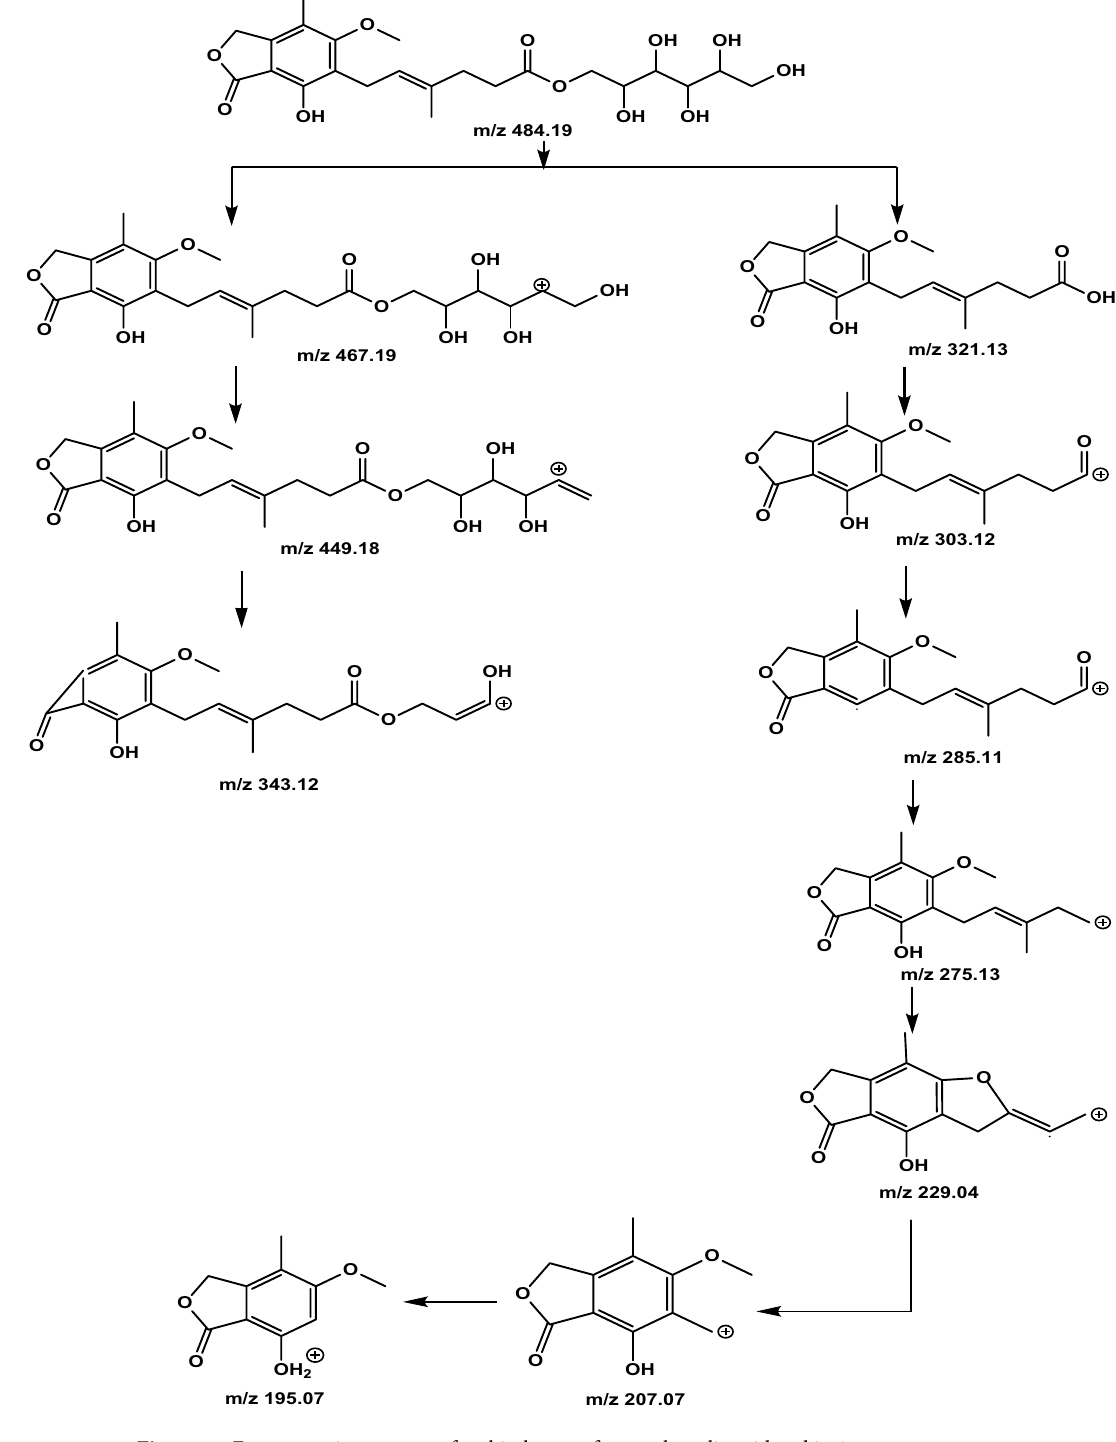
Figure 7. Fragmentation pattern of sorbitol ester of mycophenolic acid and its